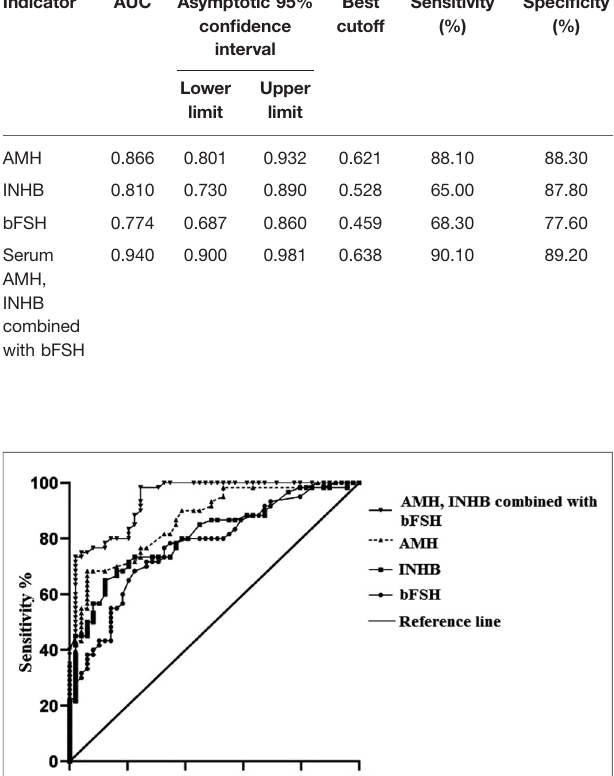
TABLE 2 | Diagnostic value of serum AMH, INHB combined with bFSH for postoperative ovarian reserve. Indicator AUC